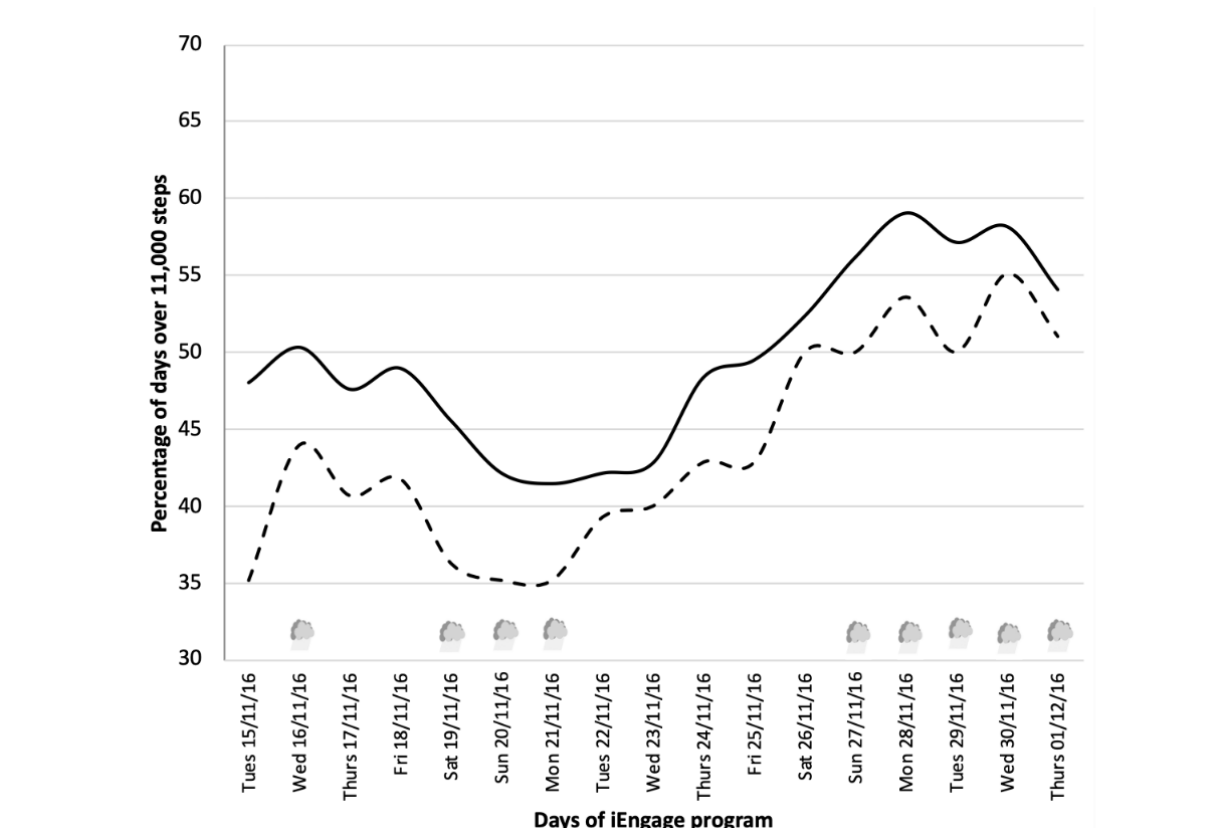
Figure 4. Average consistency rate (in %) of daily steps during the iEngage program. Consistency rate is calculated at the end of a 7-day window sliding over time; hence, the data presented in the graph start on day 7. Rainy days (N=10, between 0.3 and 14.3 mm.3h -1 ) are represented by a cloud